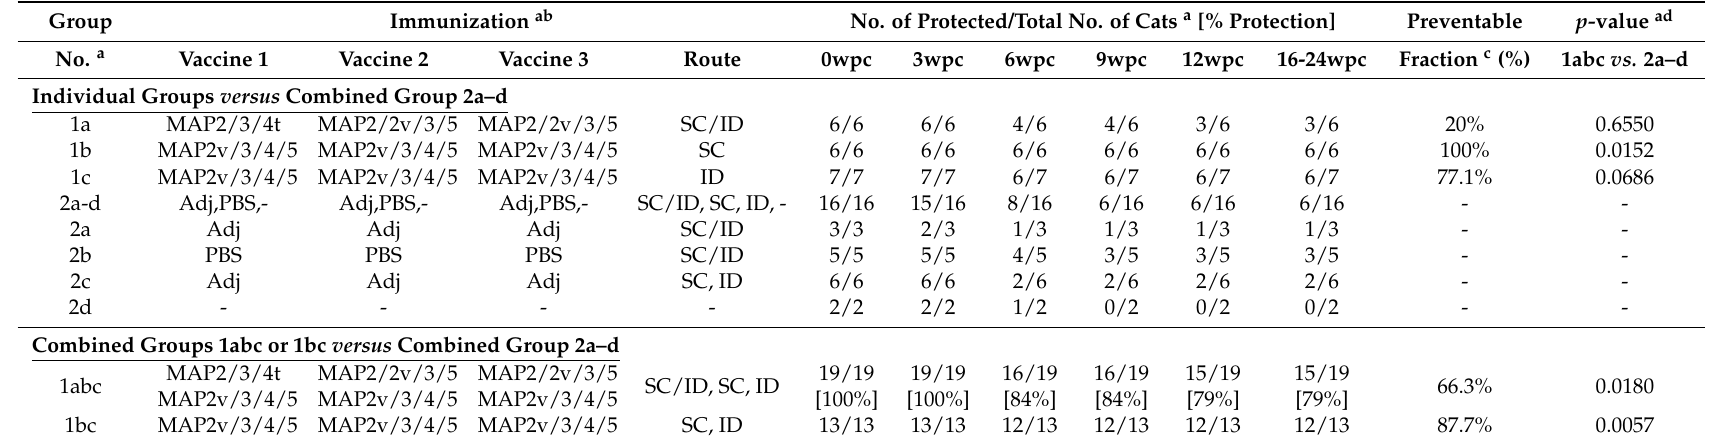
Table 3. Summary of MAP immunization and challenge efficacy a